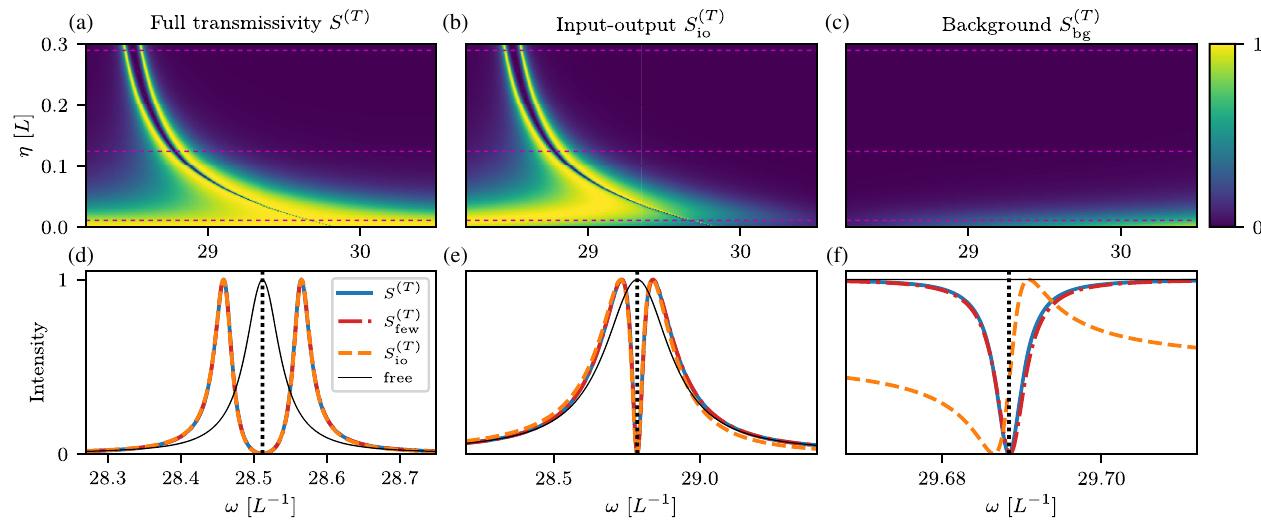
FIG. 8. Linear transmission spectra of a coupled atom-cavity system. The cavity is chosen as in Fig. 5, and the transition frequency of the atom with d ¼ 0 . 01 is chosen resonant with the ninth empty cavity mode at each mirror quality η . (a) shows the full transmissivity calculated using the linear dispersion theory as a reference. (b) shows the input-output part without the background contribution which is χ χ χ – (f) show slices at η ¼ 0 . 289 , 0.124, and 0.011, shown in (c), each calculated with three system modes ( Λ 7 ; 9 ; 11 g ). (d) Q ¼ f respectively. They correspond to a transition from strong coupling (d) via weak coupling (e) to a regime with negligible cavity S S confinement (f). In the entire range, the ab initio few-mode result ( S , red dash-dotted line) agrees well with the full result few ¼ bg io from linear dispersion theory ( S , blue solid line), with good convergence already found using a single mode χ 9 for (d) and (e) and using three modes Λ for (f). In the weak and strong coupling regimes, the input-output term alone is sufficient to model the interacting system Q (d),(e). But in the regime of strongly overlapping modes and weak confinement, background scattering plays a crucial role (c), such that input-output scattering alone gives a vastly different line shape from the full result